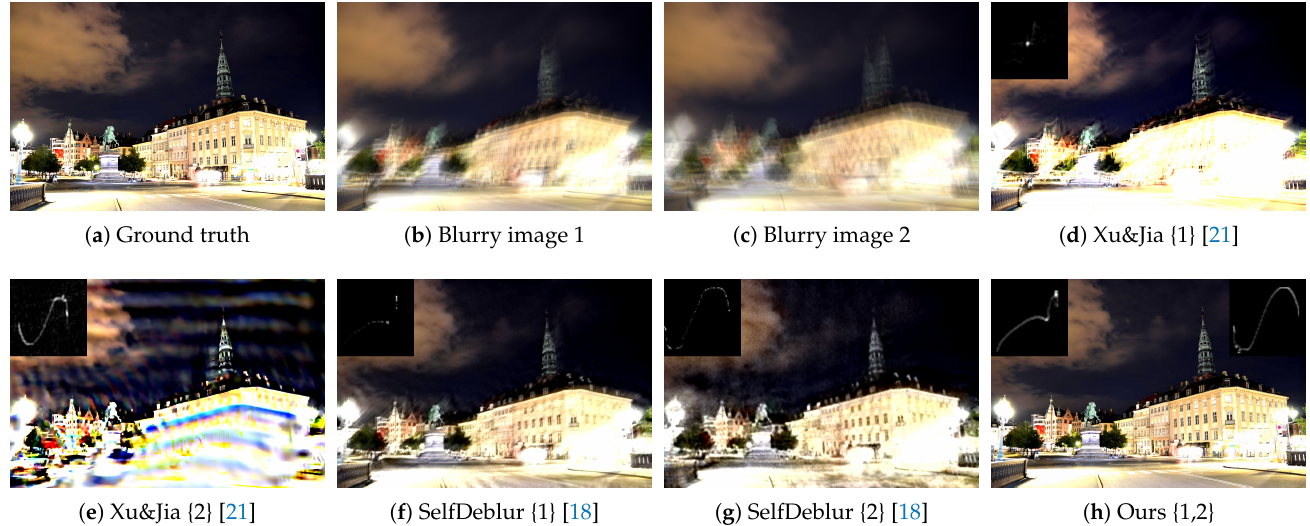
(i.e., ours {1,2} indicates our Figure 1. Visual quality comparison. The input image for each method is denoted as {} resulting image when the input images are blurry image 1 and blurry image 2). ( a ) Ground-truth image. ( b ) Blurry image with kernel size 55 55. ( c ) Blurry image with kernel size 75 75. ( d , e ) Results of [21] corresponding to ( b , c ), respectively. × × In ( d ), PSNR is 15.33 and in ( e ), PSNR is 14.45. ( f , g ) Results of [18] corresponding to ( b , c ), respectively. In ( f ), PSNR is 21.03 and in ( g ), PSNR is 20.15. ( h ) Our result. In ( h ), PSNR is